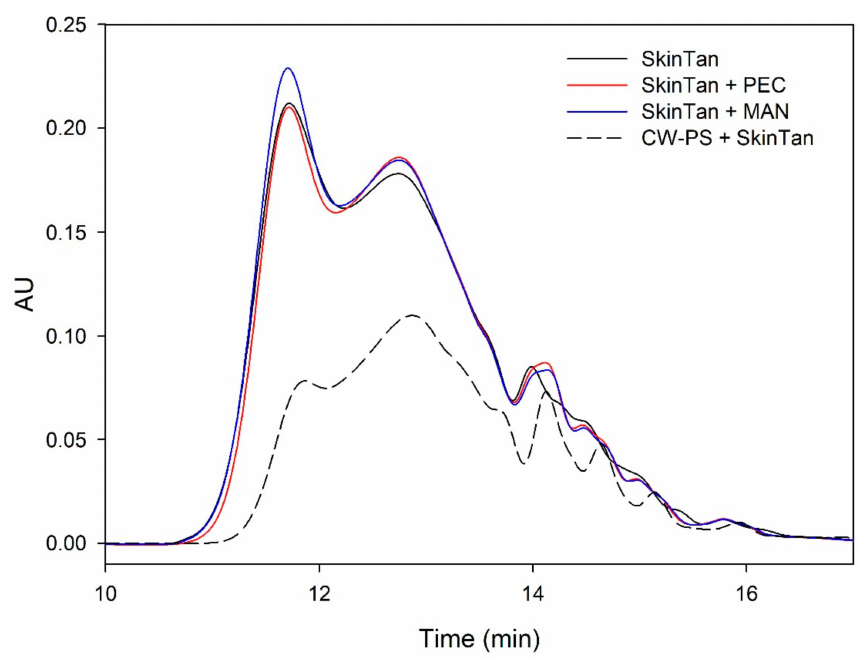
Figure 1. Analysis of the mass distribution of skin tannins by SEC. Comparison of the skin tannins in the absence (SkinTan) and presence of PEC, MAN, and PS-CW.